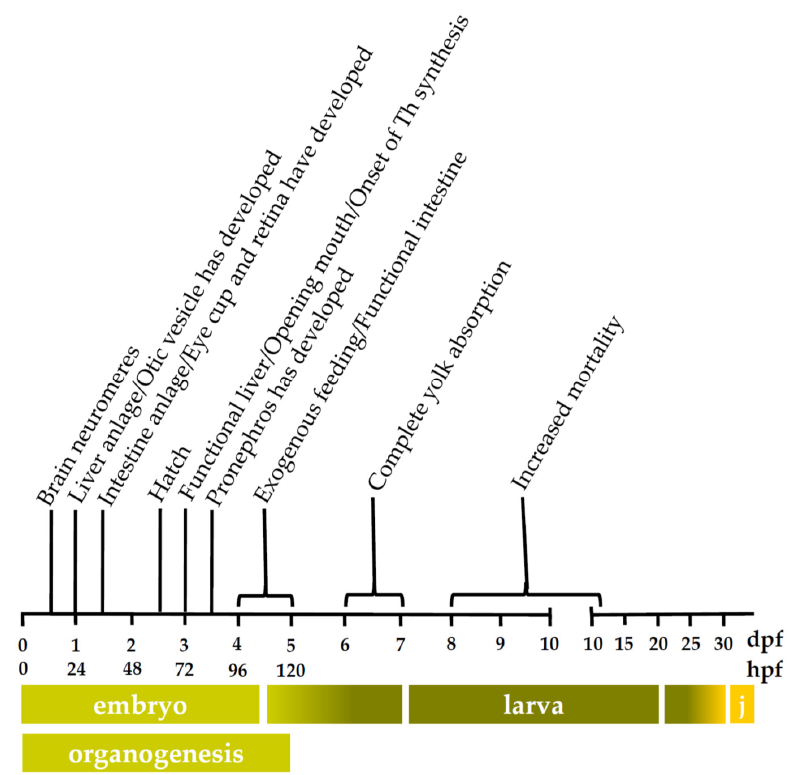
Figure 1. Timeline showing key events during zebrafish development, from fertilization to juvenile stages (j.) Color bars indicate the developmental phases with gradients representing embryo-larval and larval-juvenile transitions. The period of embryonic development includes pre-hatching stage and eleutheroembryo stage, i.e., the stage between hatching and onset of exogenous feeding [5,10]. The period of organogenesis, i.e., development of brain, heart, liver, intestine and pronephros, coincides with embryonic development. Embryo-larval transition implies the period between the onset of exogenous feeding and complete yolk absorption. Larval-juvenile transition reflects the period of metamorphosis in which the larval morphology is transformed into that of a juvenile (e.g., metamorphosis of the pigment pattern and fin morphology) [43,64]. Developmental stages of the